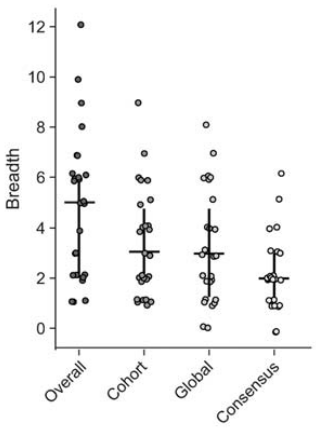
Figure 4. CD8 T cell Response breadth estimation. Minimal epitope breadth of T cell responses as determined using either the combined (overall), cohort PTE, global PTE or consensus peptide sets. Responses to consecutive peptides overlapping by 8aa were counted as a single epitope. Vertical lines indicate the interquartile range (IQR) with a horizontal line indicating the median. Circles indicate the minimal epitope breadth of each subject.